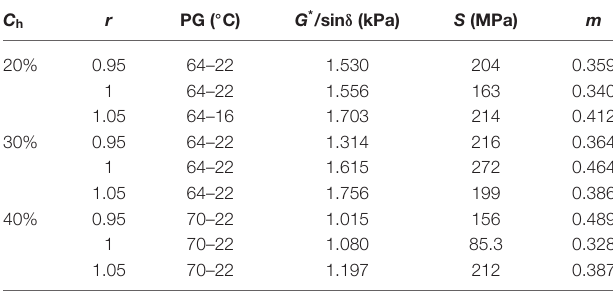
TABLE 11 | PG of polyester-based TPU-modified asphalt.